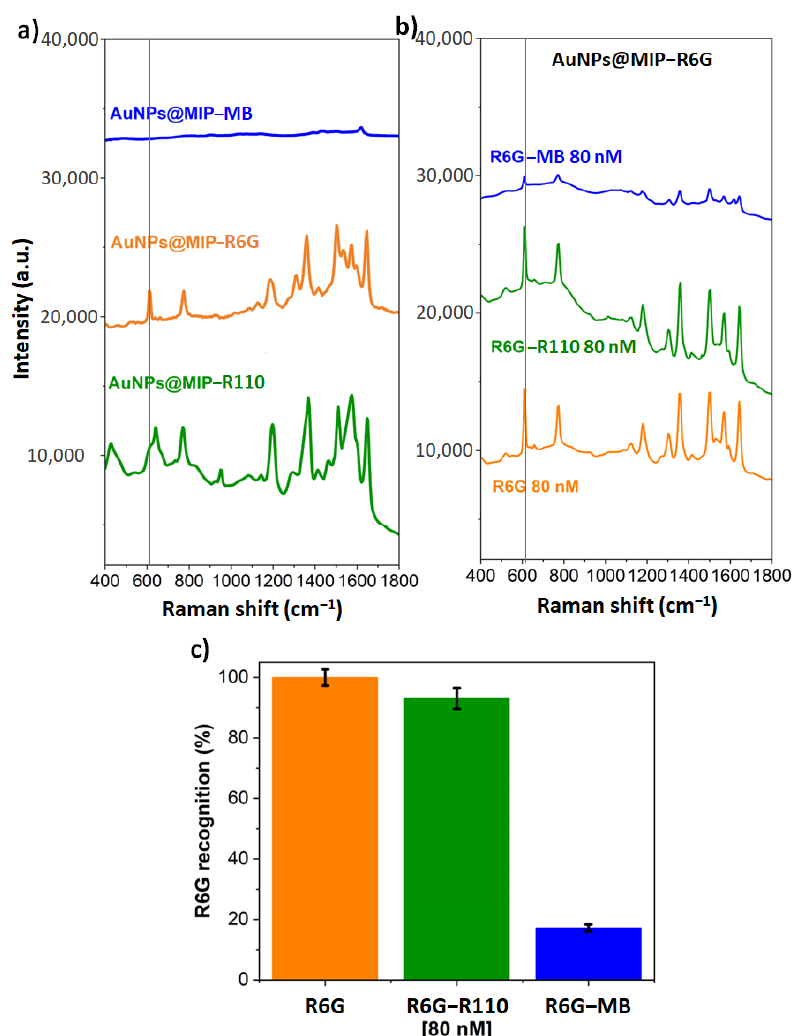
Figure 5. ( a ) Study of the relativity of R110, R6G and MB signals in SERS by polymerizing the same concentrations of each molecule in the near field, ( b ) study of the recognition of R6G in competition with R110 and MB at 80 Nm, ( c ) summary of the competitive recognition experiments.